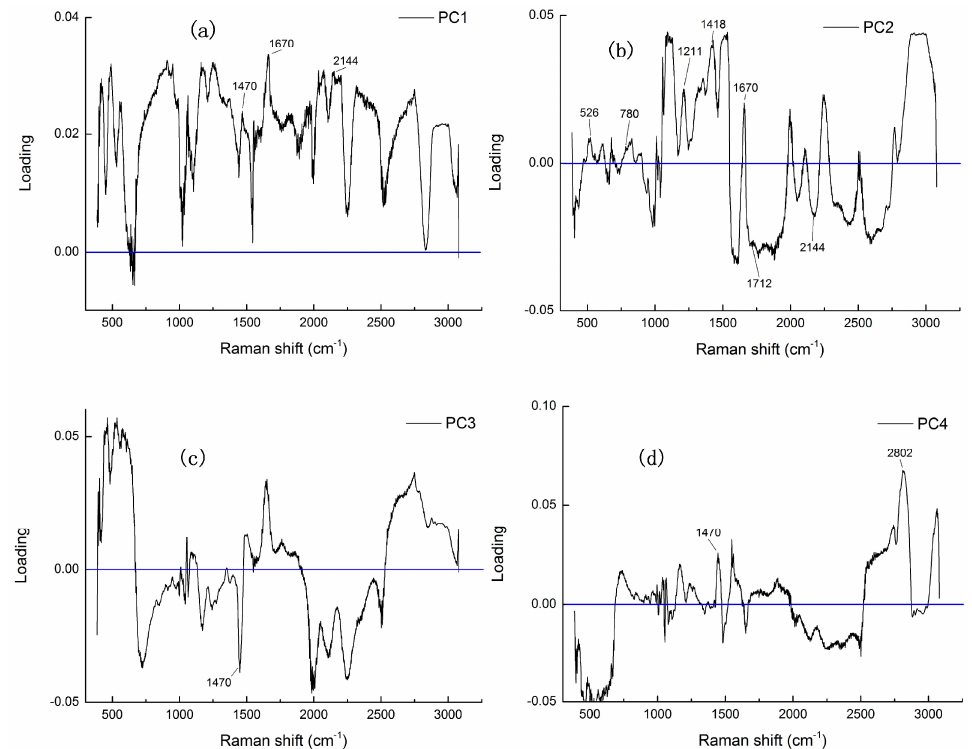
Figure 5. The first four diagnostically significant principal components (PCs). PCA loading plot for ( a ) PC1; ( b ) PC2; ( c ) PC3 and ( d ) ( a ) PC1; ( b ) PC2; ( c ) PC3 and ( d ) PC4.